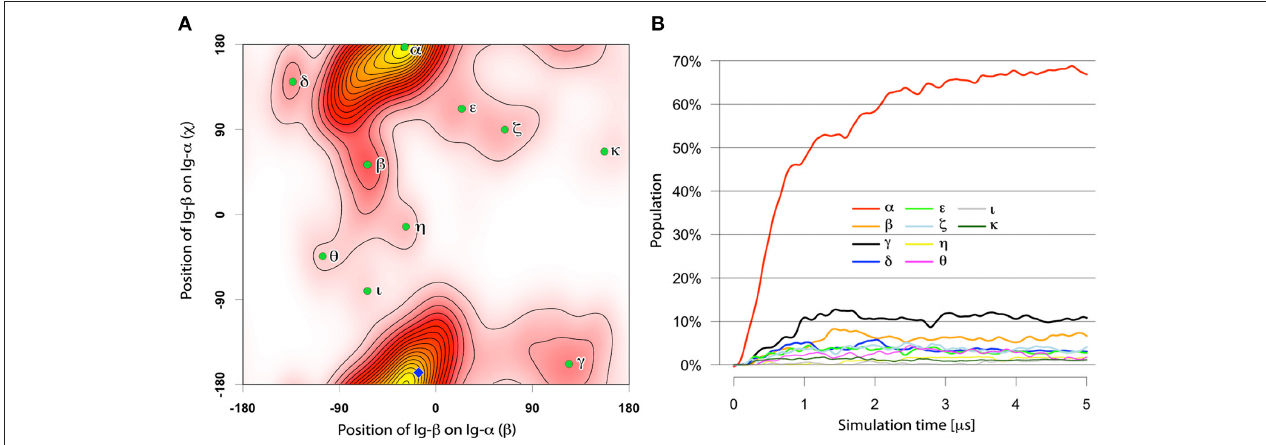
FIGURE 4 | (A) The distinct binding modes of the Ig- α /Ig- β -TMD assembly described by ORIANA and defined by β and χ -angles. Green dots mark the peaks of the binding modes. The blue diamond marks the β - and χ -angles of the representative structures for BM- α . (B) Population of different Ig- α /Ig- β TM dimer configurations as a function of simulation